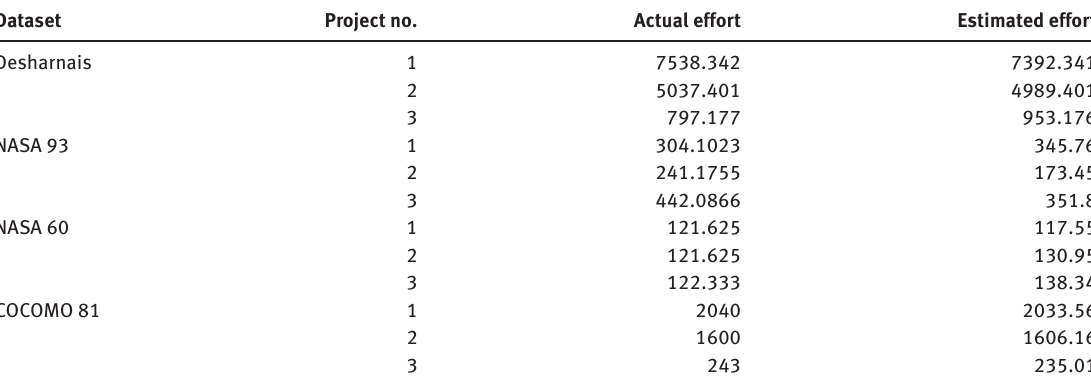
Table 2: Comparison of the Estimated and Actual